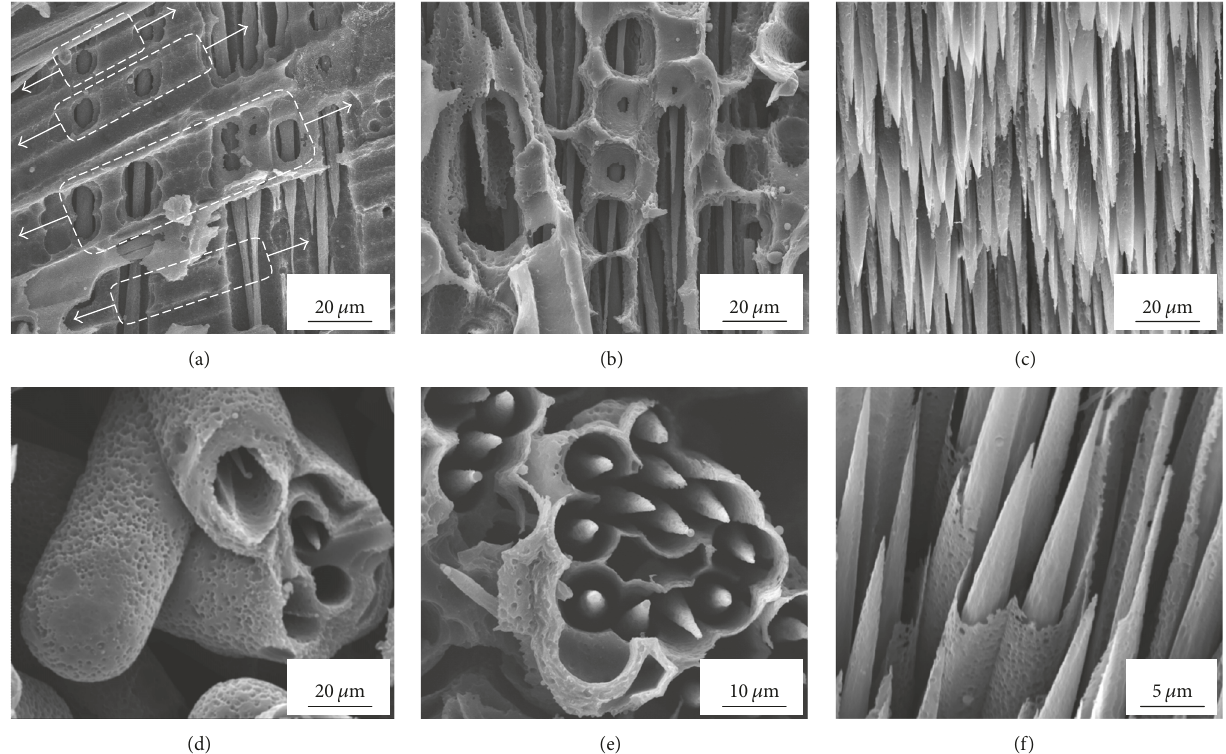
Figure 3: SEM morphologies of Directions I and II for Zone 1, Zone 2, and Zone 3 in C/C composites after ablation. (a), (b), and (c) are morphologies of Zone 1, Zone 2, and Zone 3 in Direction I, respectively; (d), (e), and (f) are those of Zone 1, Zone 2, and Zone 3 in Direction II,